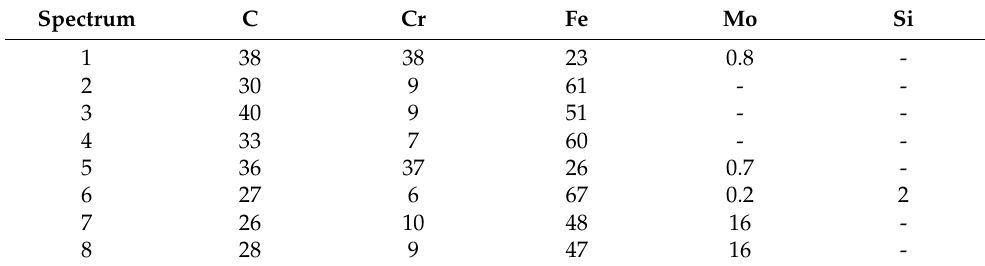
Table 5. Semi-quantitative analysis of the carbides highlighted in Figure 1. This analysis was carried out through an energy dispersive X-ray microanalysis (EDX). (%